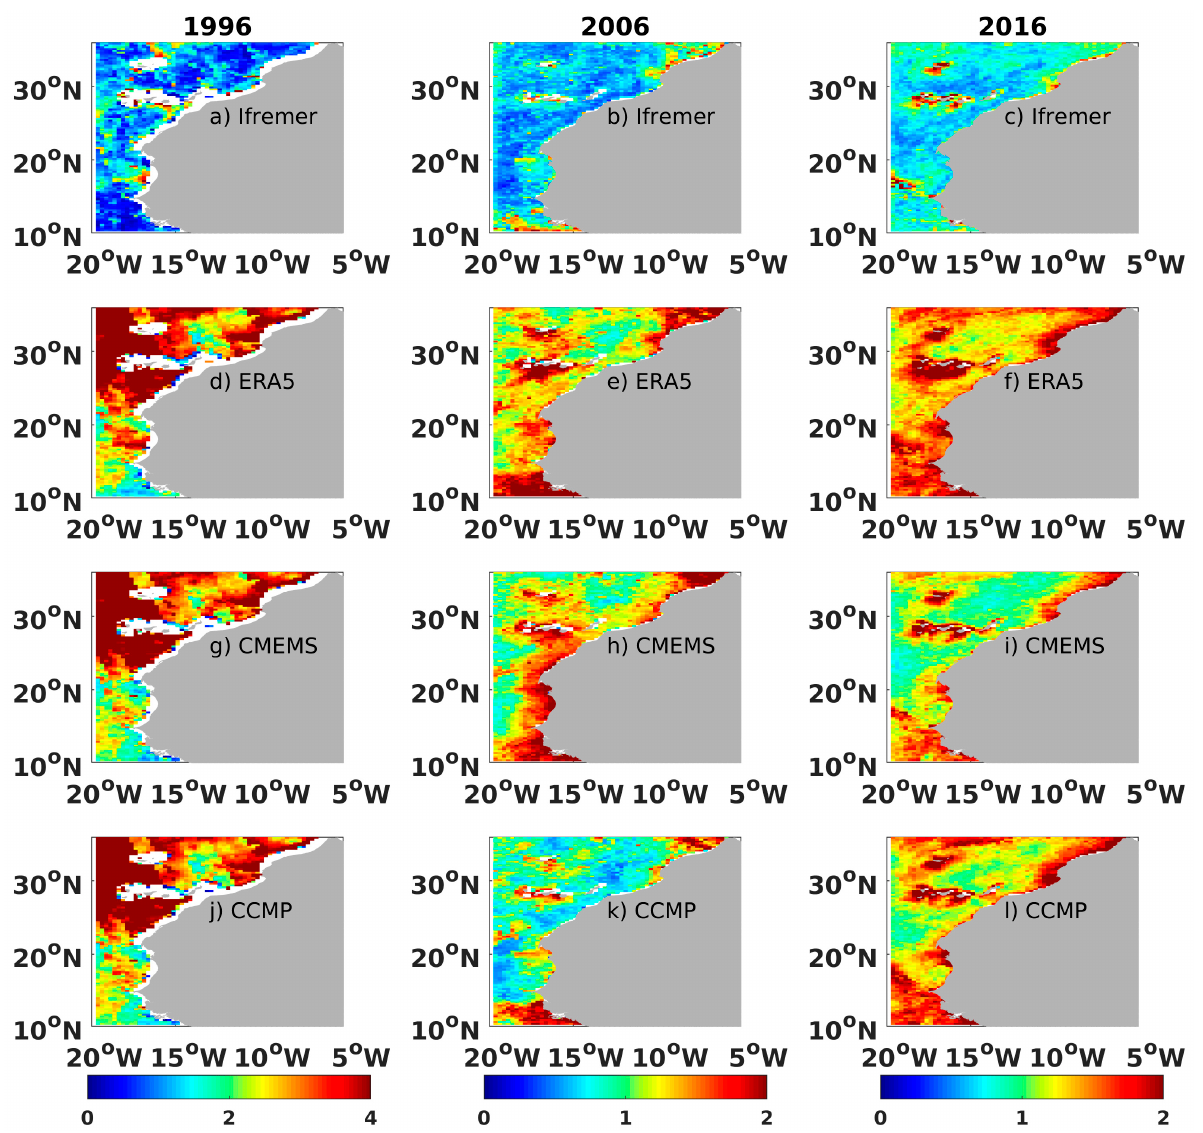
Figure A4. Spatial distributions of root mean square of zonal wind component differences between collocated scatterometer retrievals and satellite wind analyses, referenced as Ifremer, ( a – c ), ERA5 wind estimates ( d – f ), CMEMS winds ( g – i ), and CCMP winds ( j – l ). The results are drawn from data occurring, over the Canary zone, in 1996 (panels in left column), 2006 (middle column), and 2016 (right column). Color indicates RMSD values in m/s. One should notice that the color bar associated with 1996 is different from the 2006 and 2016 ones.